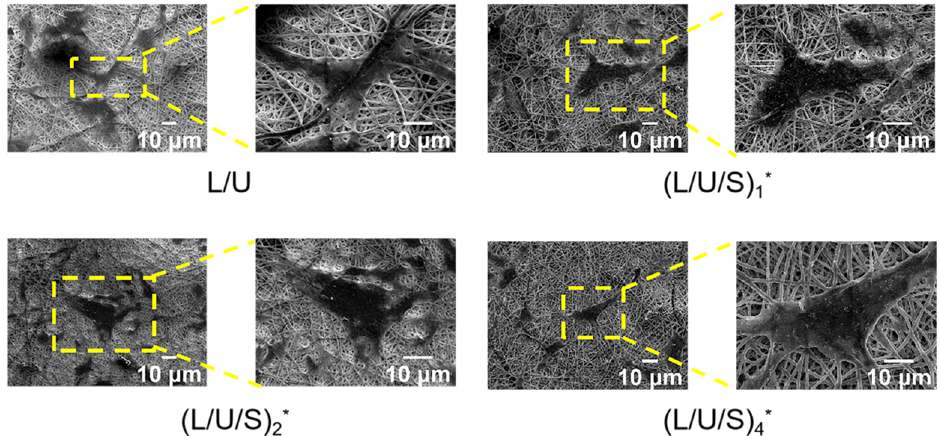
Figure 8. The cytoskeleton of HSFs on different electrospun membranes at 1, 4, and 7 day(s) (cytoskeleton-green fluorescence, nucleus-blue fluorescence). (L/U/S) 1* , (L/U/S) 2* , (L/U/S) 4* referred to the sample after (L/U/S) 1 , (L/U/S) 2 , (L/U/S) 4 were cross-linked, respectively.